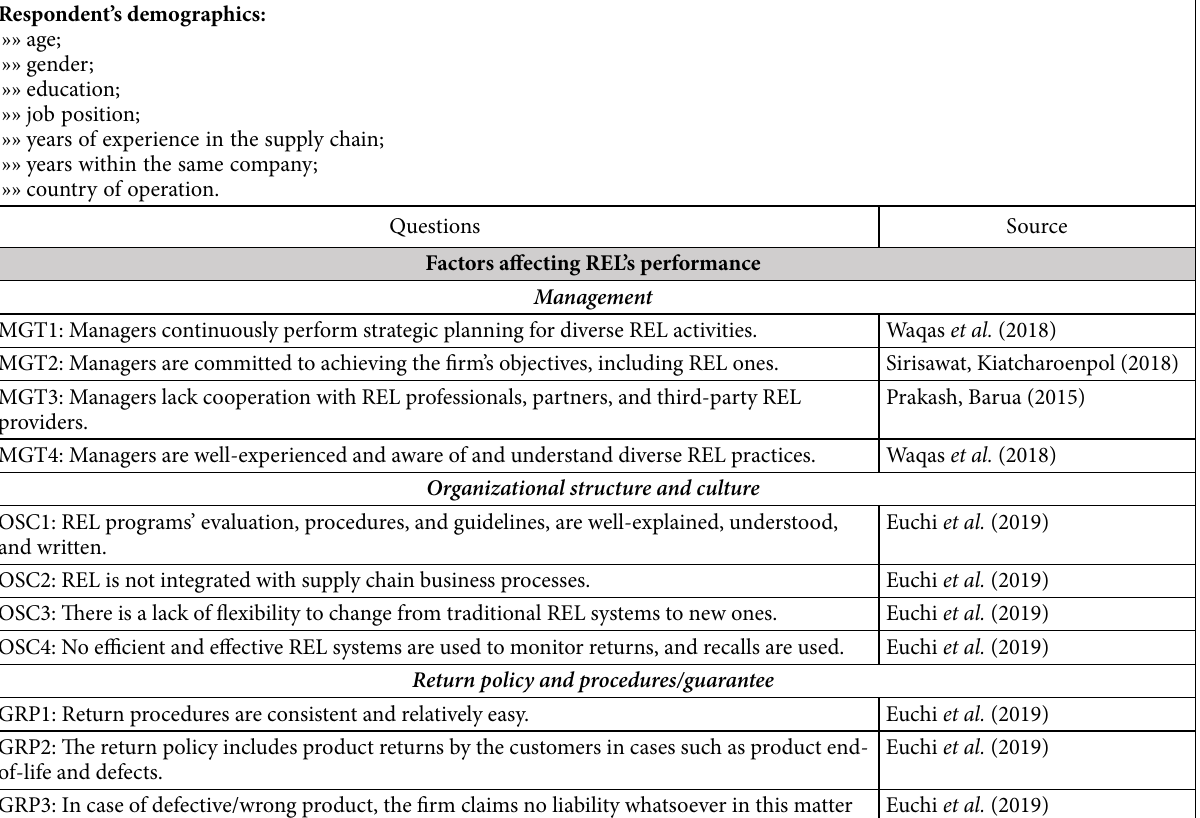
Table 5. Questions of the questionnaire sent (source: compiled by authors